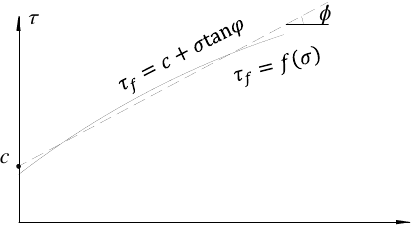
Figure 5. Mohr’s failure envelope.